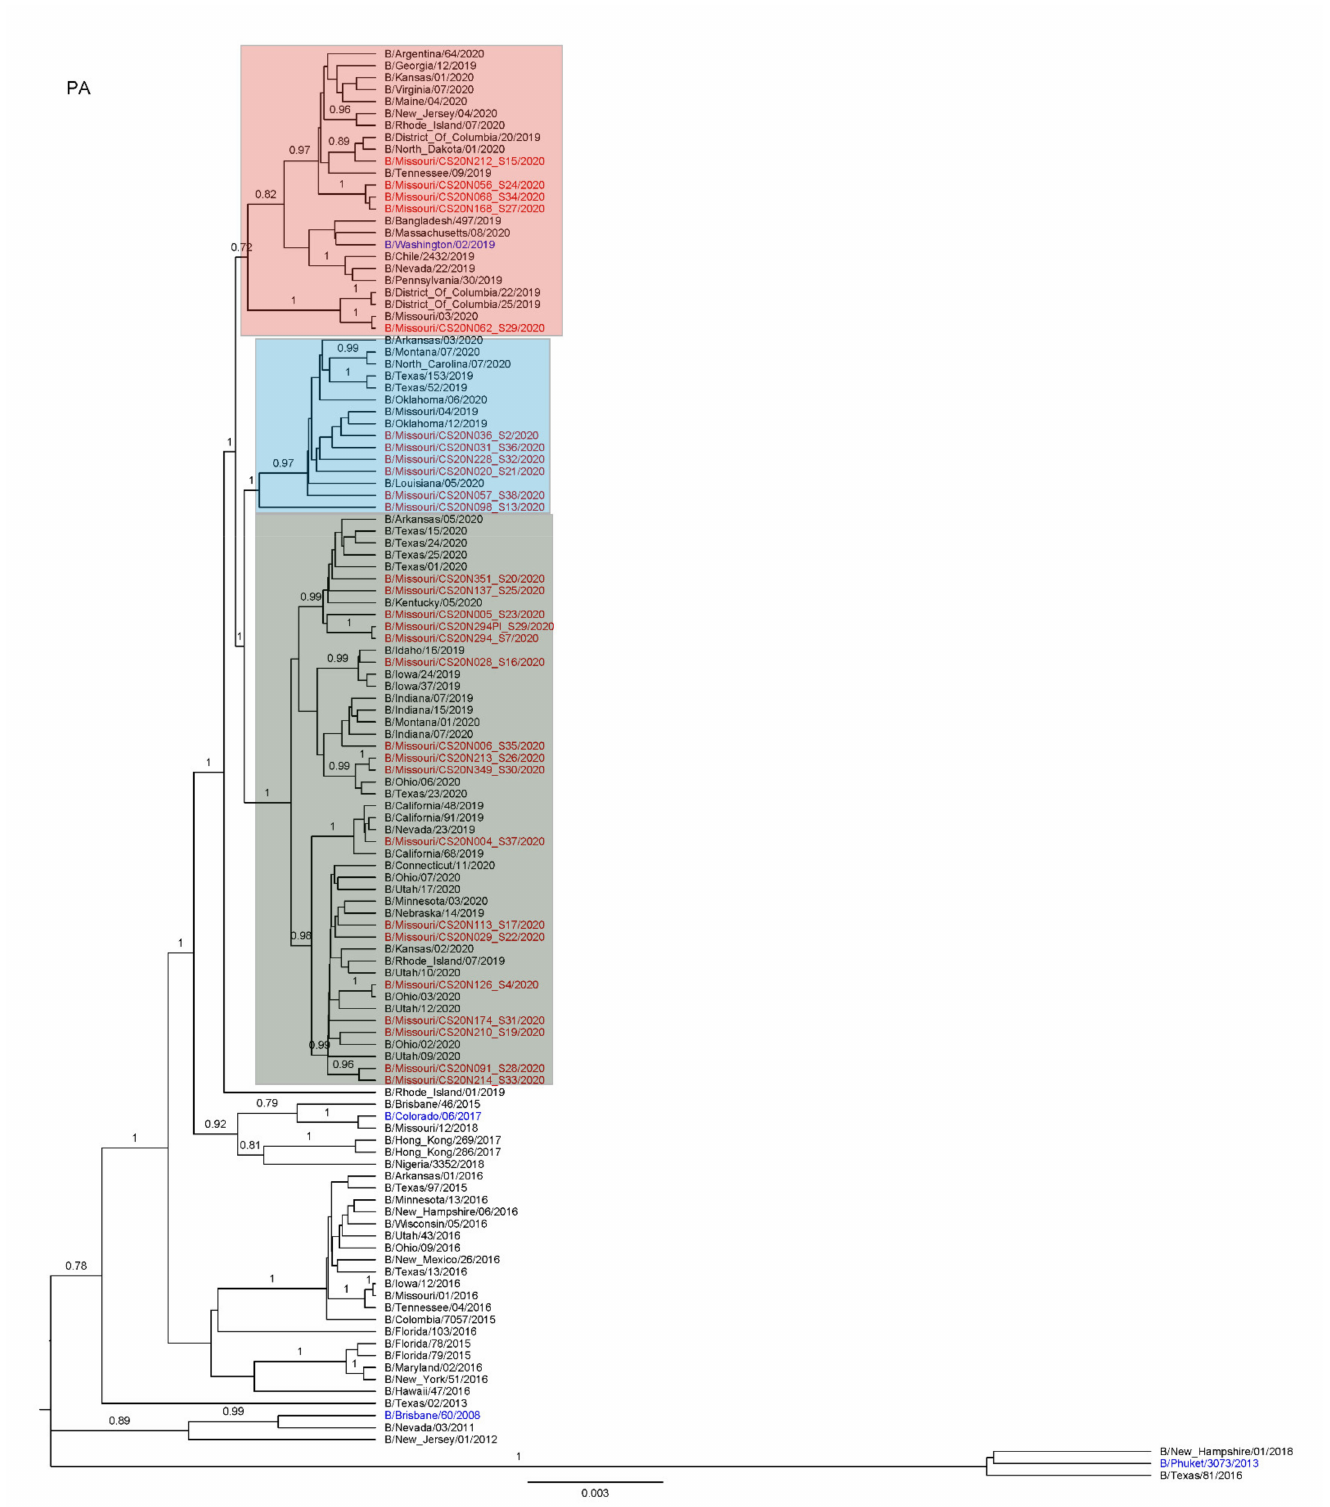
Figure A3. PA Tree. The phylogenetic analyses were performed by using BEAST2 with a Hasegawa–Kishino–Yano (HKY) substitution empirical model, strict clock model, and coalescent constant population prior. Branches with a posterior probability >0.70 were